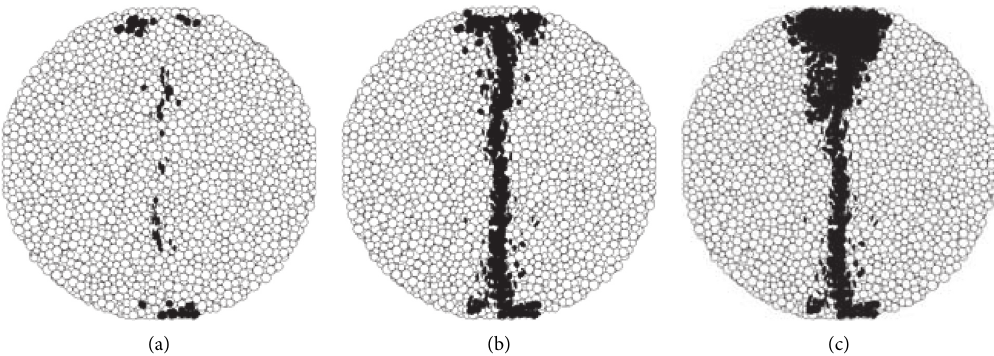
Figure 21: Microcracks distribution in CCNBD specimen (B3). (a) Crack initiation. (b) Crack growth. (c) Sample failure.